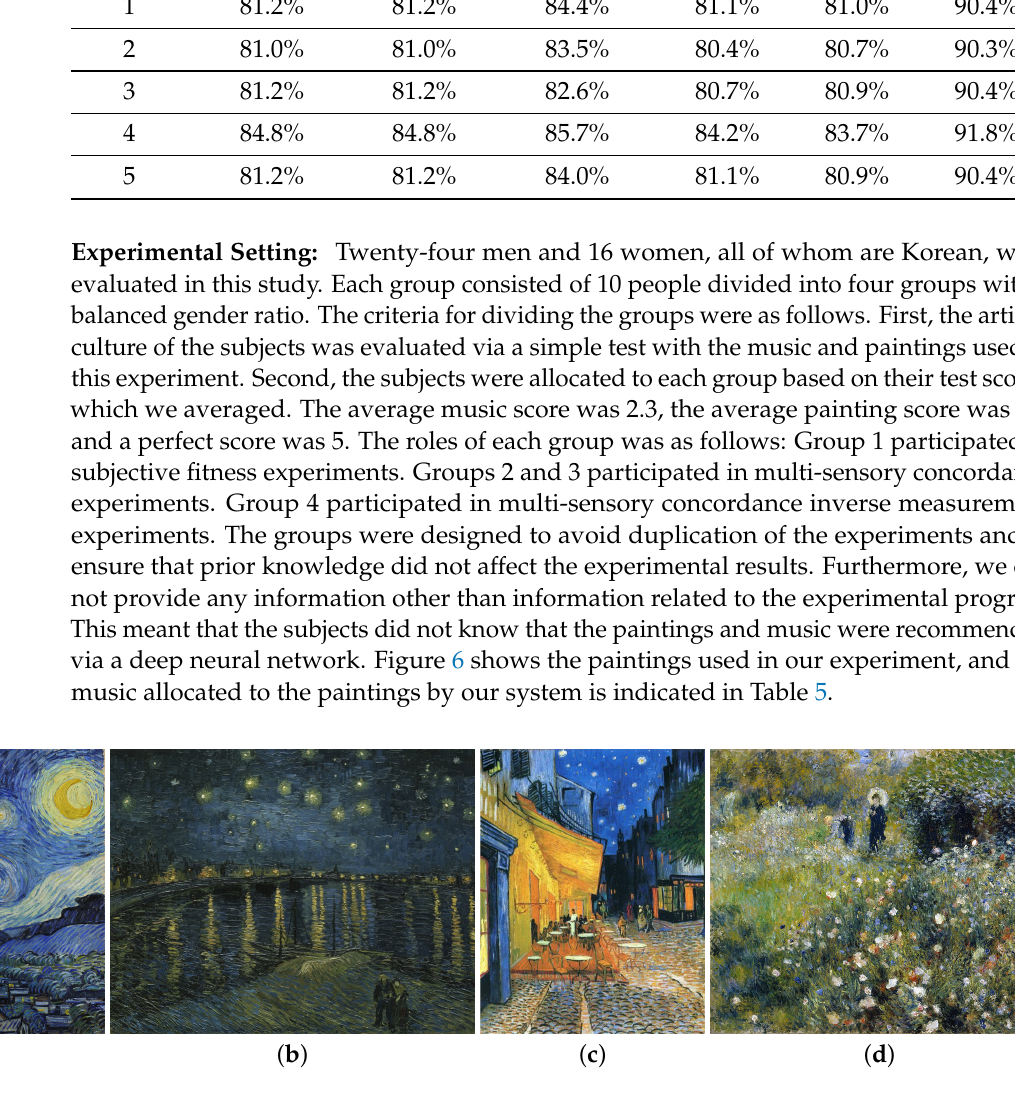
Figure 6. Paintings used in the experiments. ( a ) Starry Night; ( b ) Starry Night over the Rhône; ( c ) Café Terrace at Night; ( d ) Femme avec parasol dans un jardin. This figure is associated with Table